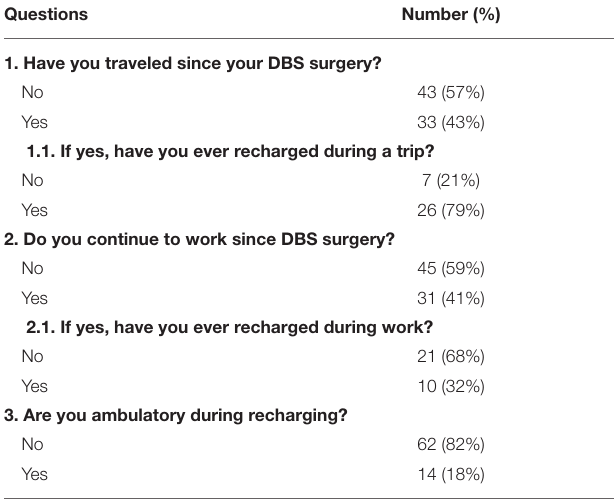
TABLE 5 | Life with a rechargeable implanted pulse generator (r-IPG) ( N = 76).